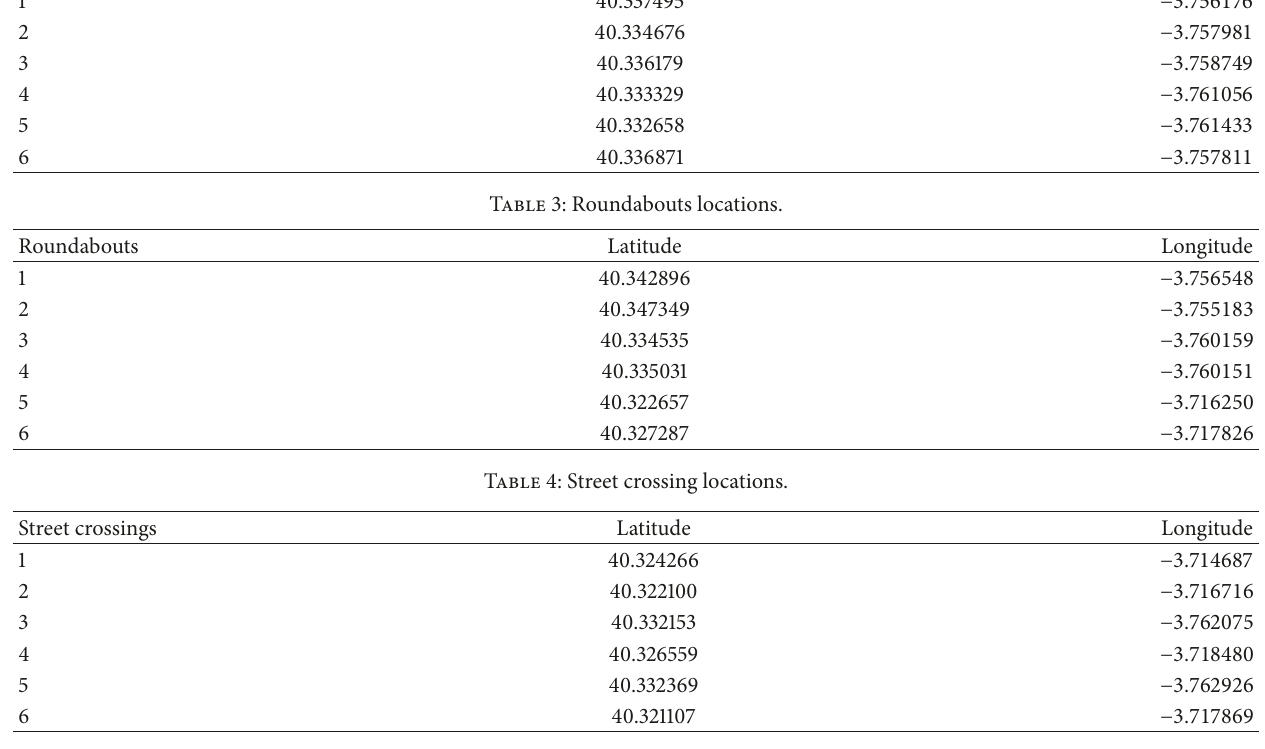
Table 5: Locations for characterizing the null class.